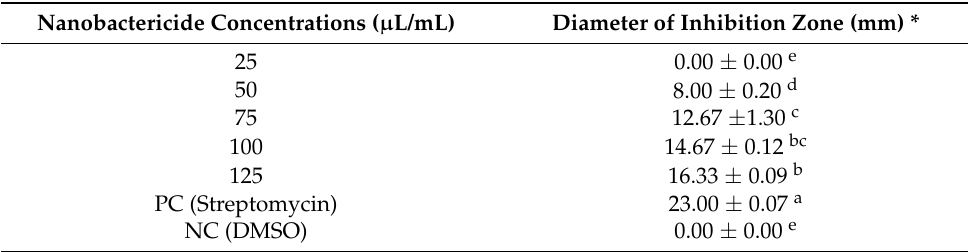
Table 1. Effect of developed nanobactericides on the growth suppression of Xanthomonas oryzae pv. oryzae 48 h after incubation